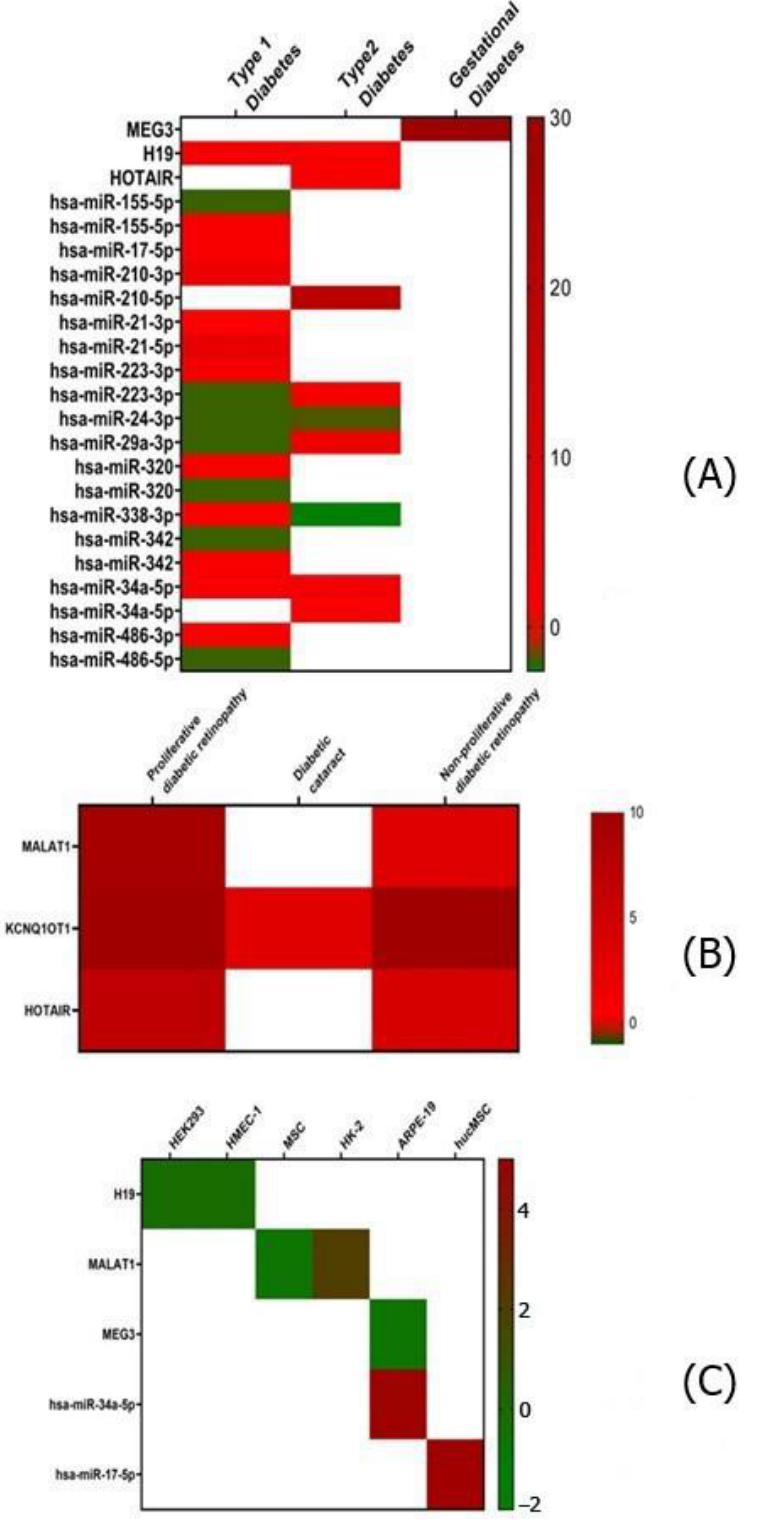
Figure 6. Heatmaps of common noncoding RNAs as putative markers for diabetes: Heatmaps of dysregulated noncoding RNAs commonly upregulated (red) and downregulated (green) in diabetes: ( A ) Differential microRNA and lncRNA expression in type 1 diabetes, type 2 diabetes and gestational diabetes. ( B ) Differential lncRNA expression in diabetes-associated complications. ( C ) Differential miRNA and lncRNA expression in cell line studies in